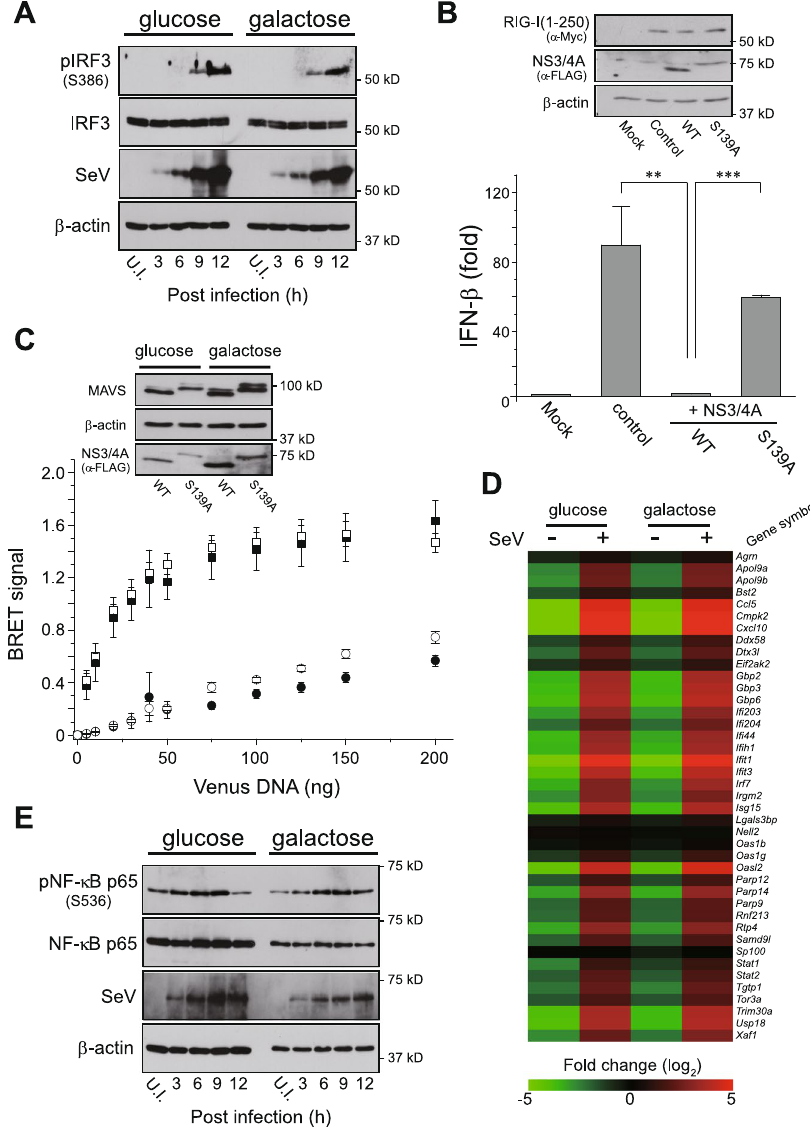
Figure 2. RLR-mediated signal transduction under oxidative conditions. ( A ) The kinetic profile of IRF-3 activation in oxidative or glycolytic medium-cultured HEK293 cells that were challenged with SeV (4 HA units/ mL). Each cell lysate was collected at the indicated time-points (3, 6, 9 and 12 h) and analyzed by Western blotting with antibodies against the specific antibody (pIRF-3; phosphorylation of Ser386). Anti- β -actin was used as the loading control and anti-SeV as the infection control. U.I., uninfected. ( B ) Oxidative medium- cultured HEK293 cells were transfected with 50 ng of empty vector (Mock) or expression plasmid for Myc- tagged RIG-I(1–250) (control) together with the IFN- β reporter plasmid. The two right lanes ( + NS3/4A) indicate that 100 ng of FLAG-tagged WT or inactive (S139A) NS3/4A serine protease expression plasmids were also co-transfected with the RIG-I(1–250) plasmid. The immunoblot on the top represents an expression profile of Myc-tagged RIG-I(1–250) and FLAG-tagged NS3/4A mutants as well as the loading control of endogenous β -actin. Error bars indicate SD ( n = 3; Unpaired t -test; ** P < 0.01 and *** P < 0.001, respectively). ( C ) BRET saturation assay of MAVS oligomerization in glycolytic versus oxidative media. HEK293 cells were co-transfected with 5 ng NLuc-MAVS expression plasmid and increasing amounts (0–200 ng) of Venus-tagged MAVS plasmid along with 200 ng of WT (circles) or S139A (squares) FLAG-tagged NS3/4 A plasmids, and analyzed 24 h later using a BRET saturation assay. Closed and open symbols represent glycolytic and oxidative conditions of HEK293 cells, respectively, and inset blots show Western blots from the BRET saturation point of each curve by immunoblotting with the indicated antibodies. Error bars indicate SEM ( n = 3). ( D ) Heat maps of microarray analysis. Total RNAs were isolated from glycolytic and oxidative cultured conditions of primary MEFs that were unchallenged ( − ) or challenged ( + ) with SeV (30 HA units mL − 1 ) for 6 h, and microarray analysis was performed. The heat map was generated by MeV software 42 , and the color indicates the distance from the median of each row. ( E ) Similar to ( A ), except that J774A.1 macrophages were challenged with SeV (2 HA units/mL). U.I.,